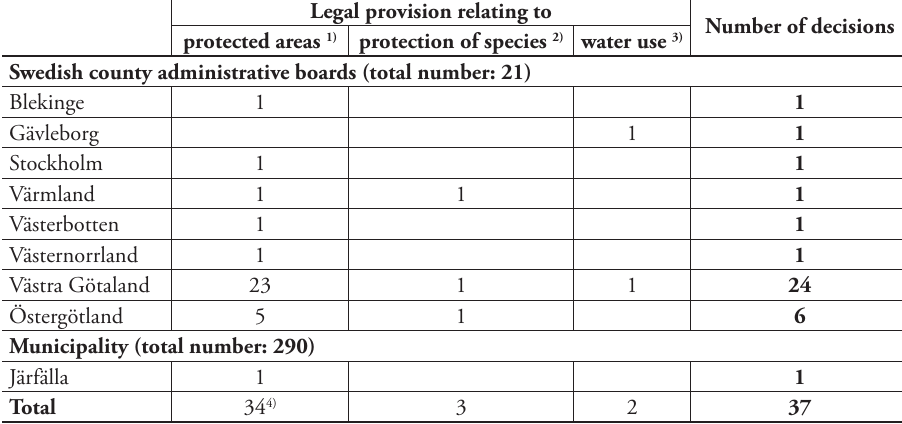
Table 1. Decisions taken by Swedish county administrative boards (CABs) and municipalities in 1999– 2012 involving an order for environmental compensation. Note that a decision may refer to more than one legal provision; the right-hand column indicates the actual number of